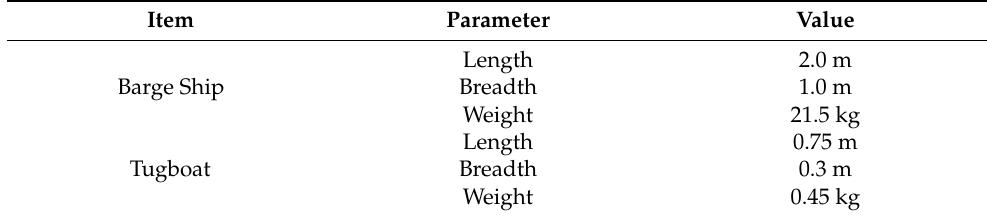
H control framework. 